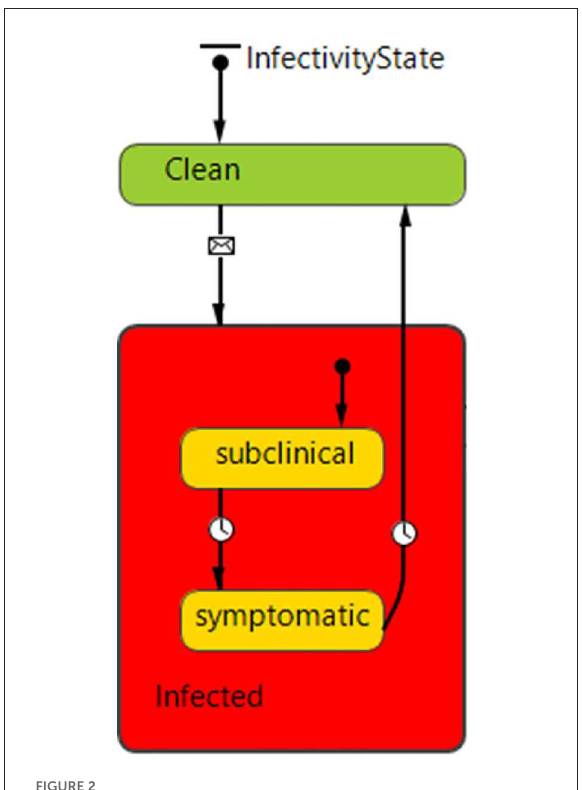
FIGURE2 InfectivityState state chart defining disease states and transitions for hog producer agents. Each agent starts in the “Clean” state (no disease) and can transition to the infected state, which is a composite state consisting of subclinical (asymptomatic) and symptomatic sub-states. Transitions are regulated by messages and timeout conditions (2 days between subclinical and symptomatic, 50 days from Infected symptomatic to Clean—susceptible). The feed mill and slaughter plant agents can only be clean or